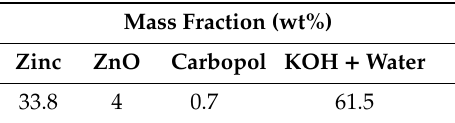
Table 1. Composition of the zinc